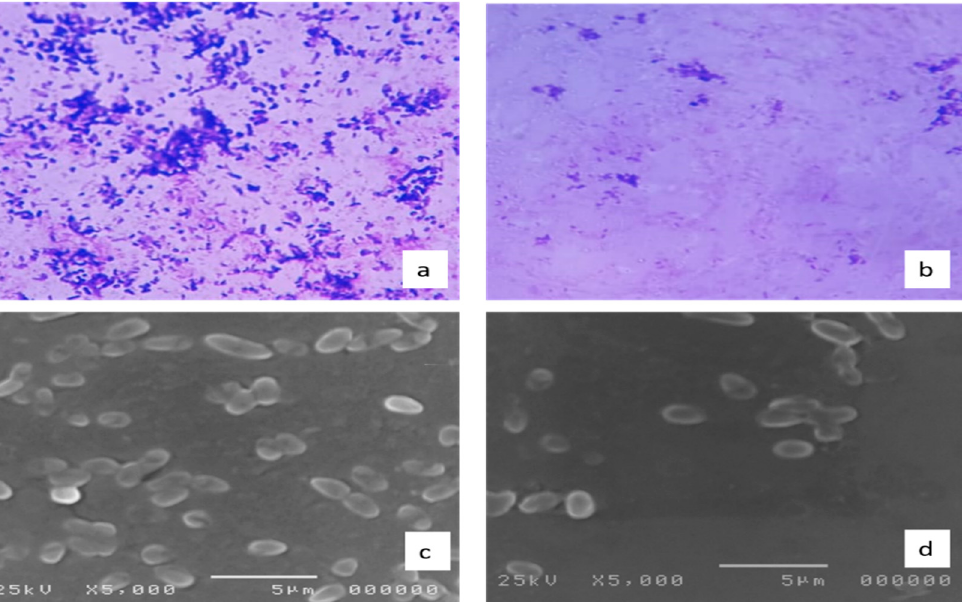
Figure 8. A representative example of the decrease in biofilm formation by S. enterica isolates ( a , b ) viewed by the light microscope, and ( c , d ) viewed by the scanning electron microscope before ( a , c ) and after ( b , d ) treatment with CRME.